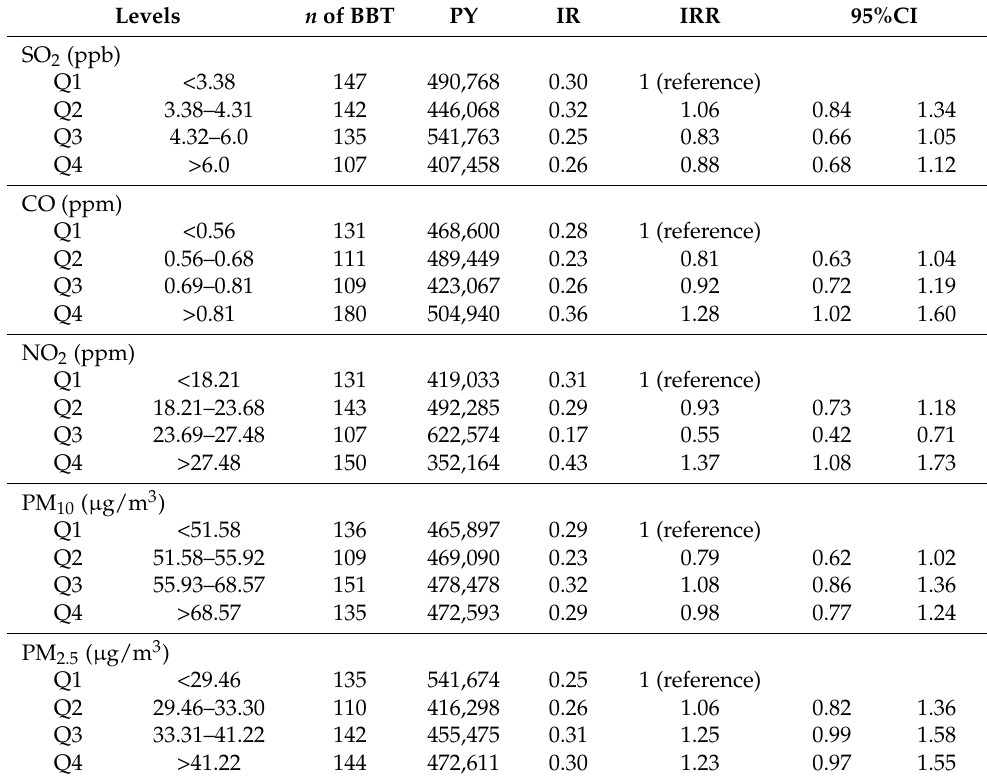
Table 2. The incidence rates (IRs) and crude incidence rate ratios (IRRs) of BBT in the residents exposed to each quartile of air pollutants.